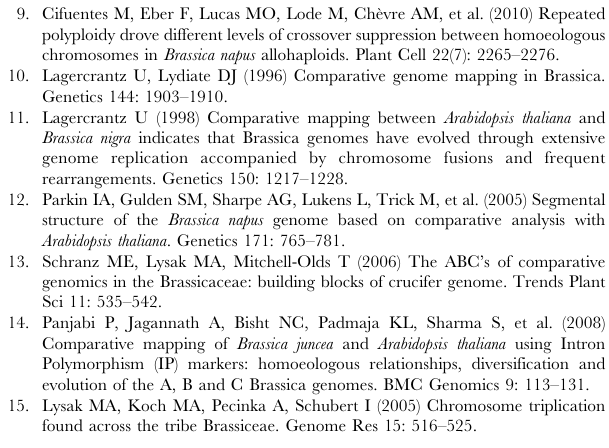
Figure S2 Neighbour joining tree of six Brassica crop species constructed based on the chloroplast gene matK sequence. The numbers on the nodes represent percentage from bootstrap analysis of 1000 replicates. Table S1 Assignment of different species of tribe Brassiceae to the Rapa/Oleracea or the Nigra lineages based on chloroplast genome analysis. Haploid chromo- some number of the species as well as the species in which genome